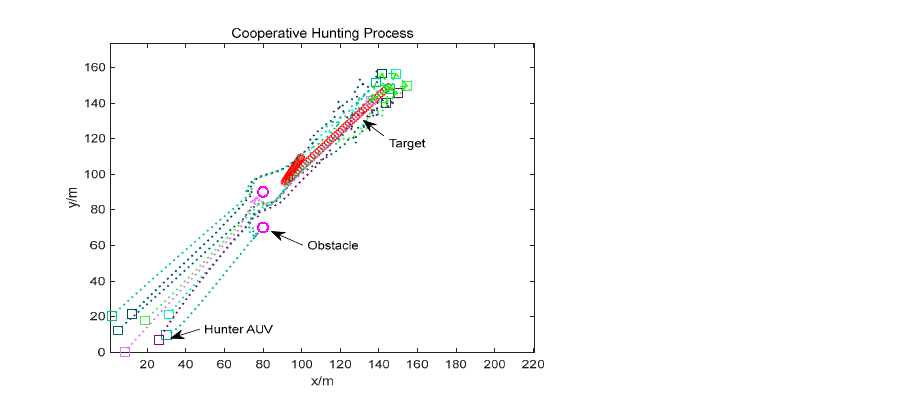
formed around the target finally. In Figure 5c, it is shown that the cooperative hunting